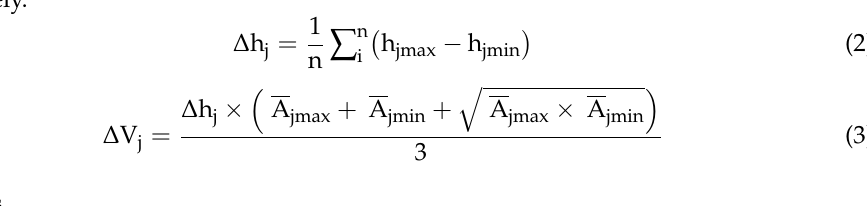
Figure 1. The distribution of water bodies on the TP. ( a ) is the seasonal water in 2000; ( b ) is the seasonal water in 2018; ( c ) is the minimum lake extent in 2000; ( d ) is the minimum lake extent in 2018; ( e ) is the maximum lake extent in 2000; ( f ) is the maximum lake extent in 2018. At the same time, we calculated the LWLC intra-year and LWSC intra-year based on the LA min and LA max obtained in each year. ∆ h j represents the average LWLC intra-year of lake j from 2000 to 2018. h jmin and h jmax represent the LWL min and LWL max of the lake j in each year, respectively. According to the acquired lake area and the change in LWL, the LWSC was then calculated. ∆ V j represents the LWSC intra-year of lake j from 2000 to 2018, while A jmin and A jmax represent the average LA min and average LA max from 2000 to 2018,